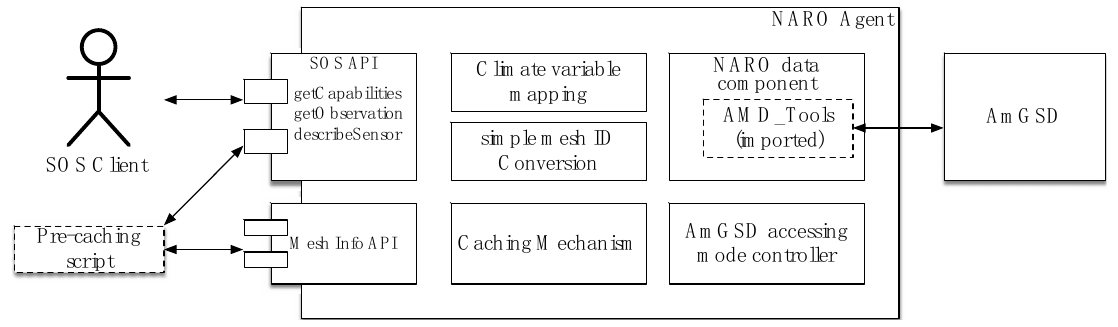
Figure 2. NARO (National Agriculture and Food Research Organization) Agent diagram. SOS (Sensor Observation Service).